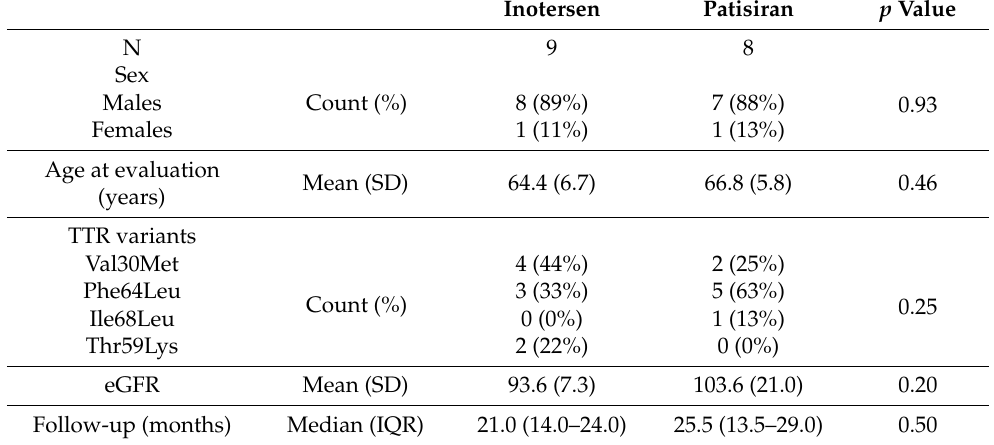
Table 1. Demographic and clinical characteristics of the two treatment groups. Categorical variables are expressed as count and percentage (%). Numerical variables are expressed as mean ± standard deviation (SD) or median and interquartile range (IQR). N represents the number of enrolled subjects in each